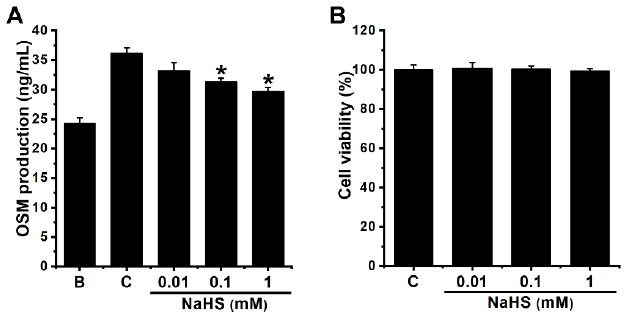
Figure 1. Inhibition of OSM production by NaHS in dHL-60 cells. ( A ) Cells (5 × 10 5 /mL) were pretreated with NaHS (0.01 to 1 mM) for 1 h, followed by GM-CSF-stimulation (5 ng/mL) for 4 h. ( B ) Cell viability was assessed by means of an MTT assay. Blank (B) corresponds to PBS treated cells without GM-CSF stimulation, and control (C) corresponds to PBS treated cells stimulated by GM-CSF. Results are expressed as the mean ± SEM from the three separate experiments. * p < 0.05, as compared with the PBS treated cells stimulated by